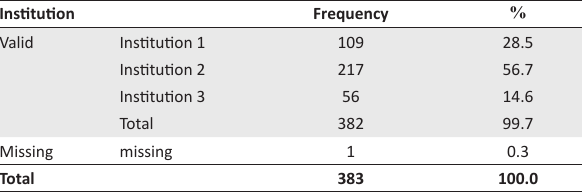
TABLE 1: Institutional distribution of respondents.